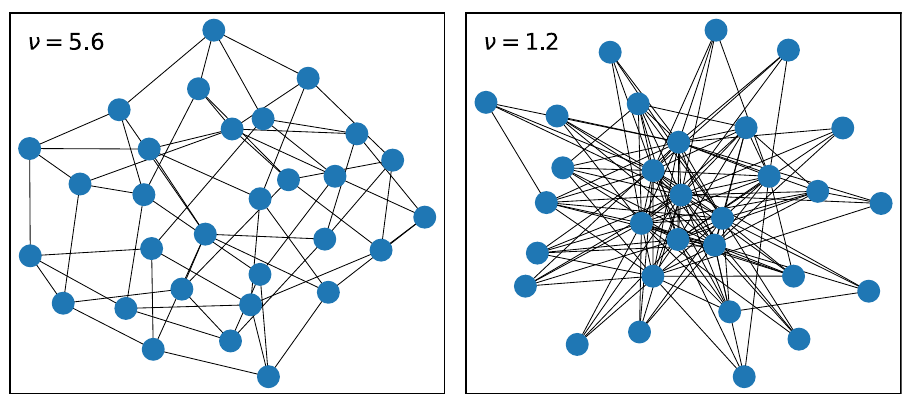
Fig 4. Instances of random networks with different degree exponents ν . The case ν > 2 (left) corresponds to a homogeneous network in which individuals all have a similar number of neighbours. The case ν < 2 (right) is heterogeneous: the central individuals are well-connected whilst the peripheral individuals are not.